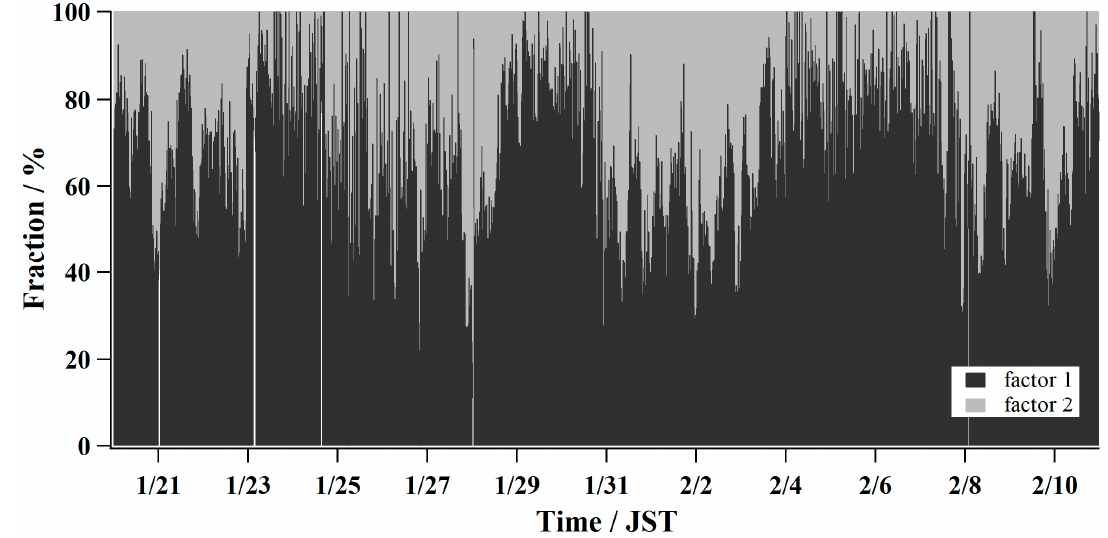
Figure 8. Fraction of Factor 1 and Factor 2 of organics analyzed by Positive Matrix Factorization (PMF) method.